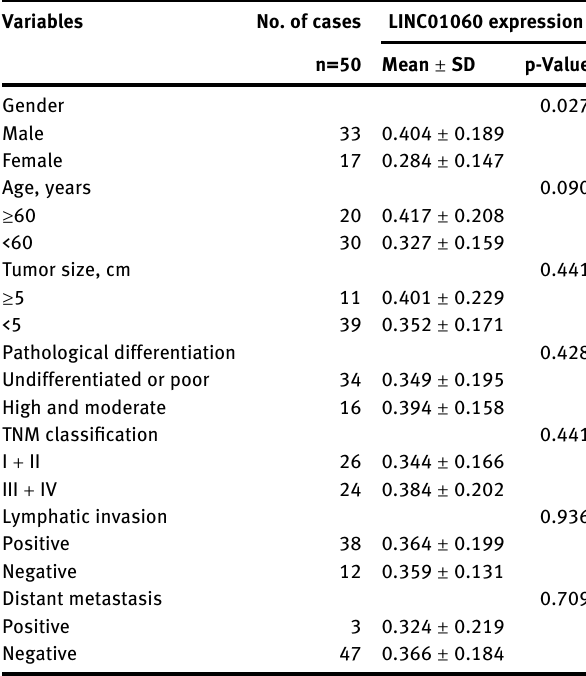
Table  : Correlation of the relative expression levels of the LINC  with the clinicopathological factors of patients.